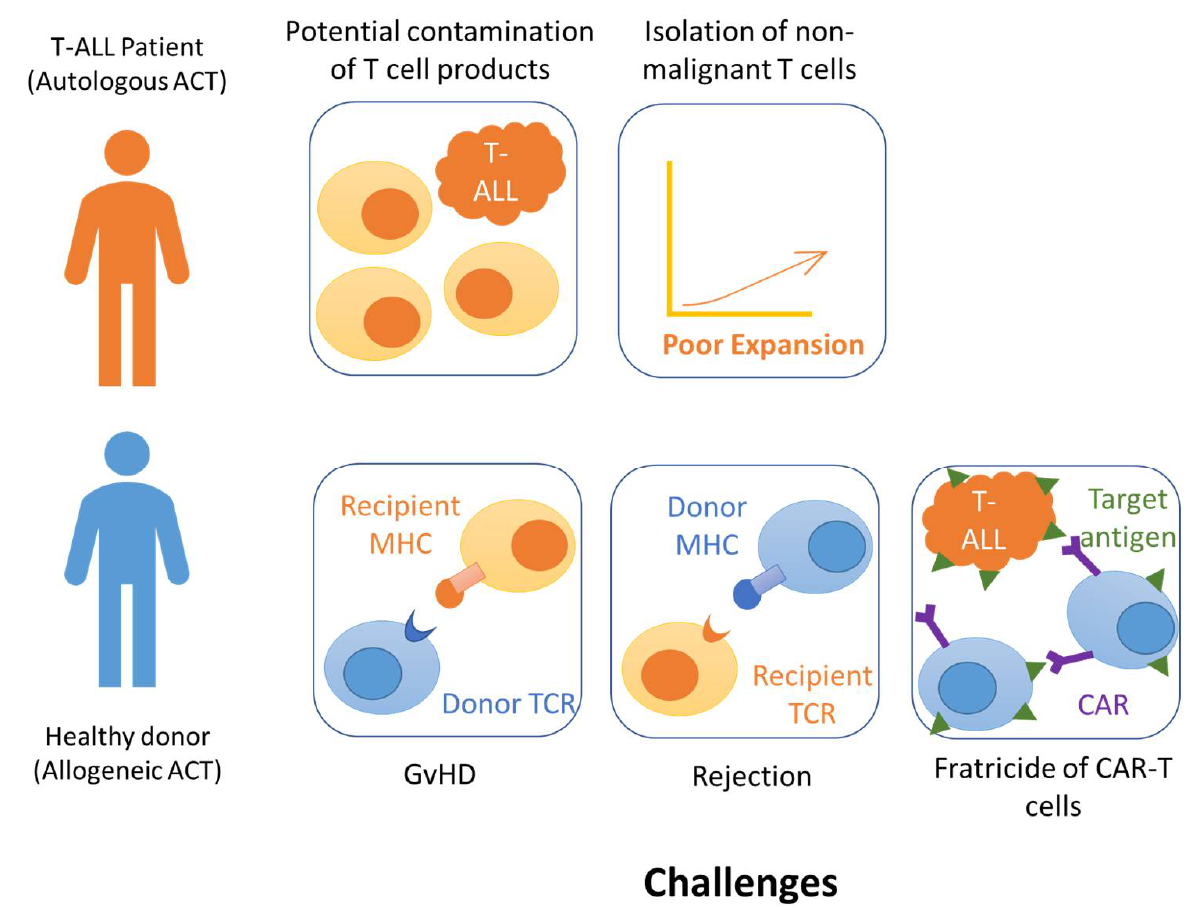
Figure 1. Challenges of CAR-T therapy for T-ALL.